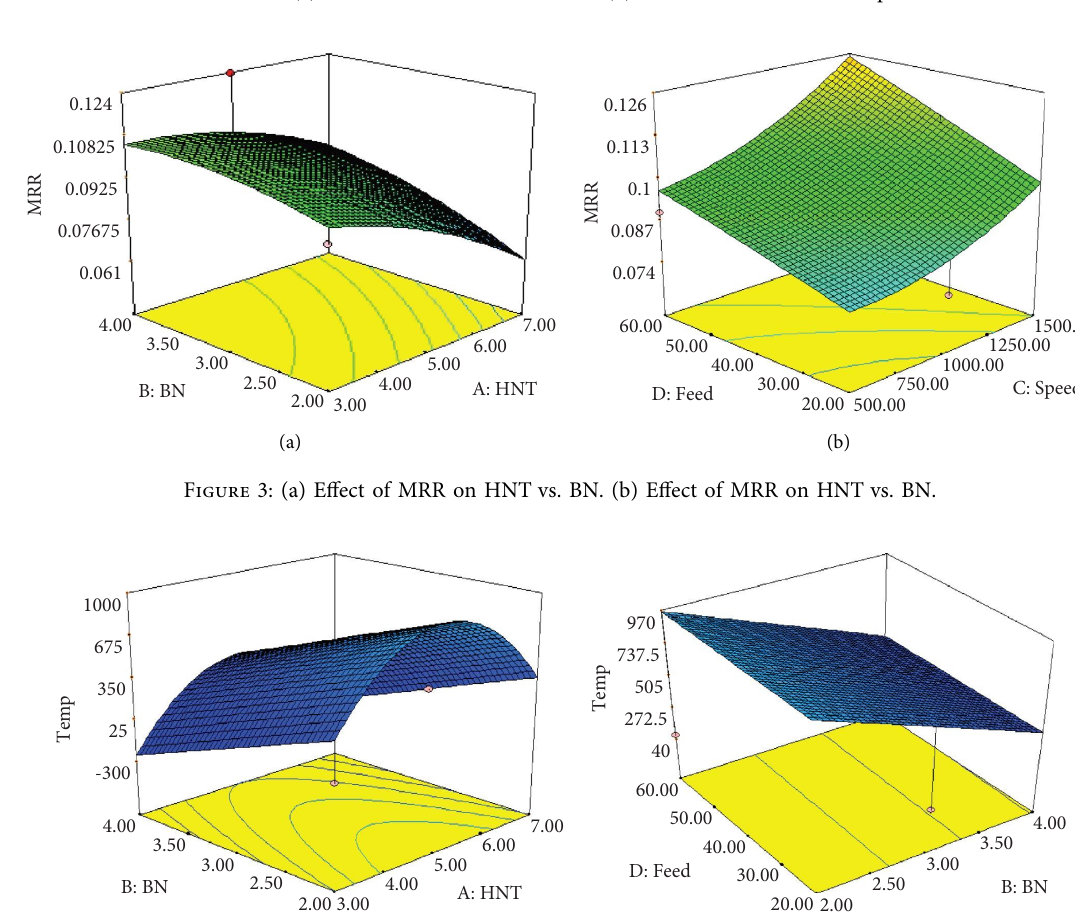
Figure 2: (a) Efect on Ra on BN vs. HNT. (b) Efect on Ra on feed vs.